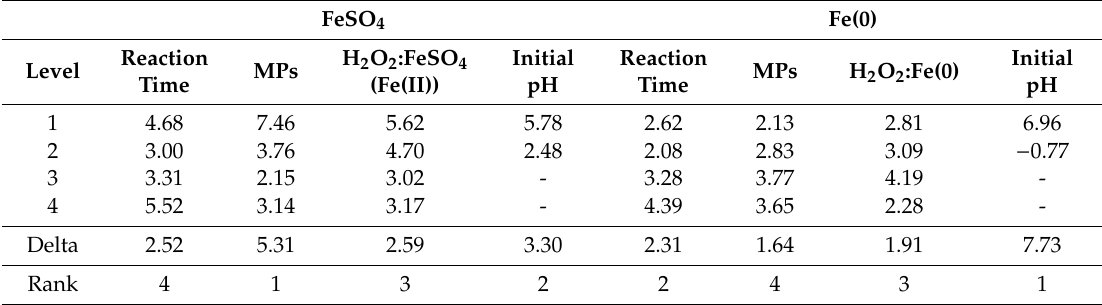
Figure 3. Main e ff ect plot for the signal-to-noise ratio for FeSO 4 treatment (top) and Fe(0) treatment (bottom). Units: Reaction time (min); DOC (mg / L); H 2 O 2 :FeSO 4 , H 2 O 2 :Fe(0) (molar ratio). Table 6. Response for the mean SN ratio; condition: Smaller is